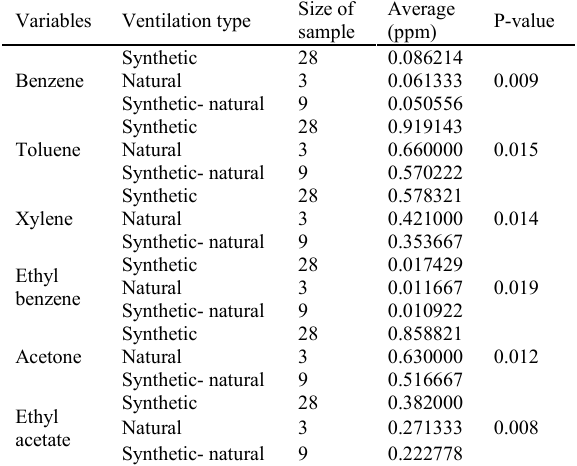
Table 4. The effect of the type of hair salon on the concentration of volatile organic compounds variables